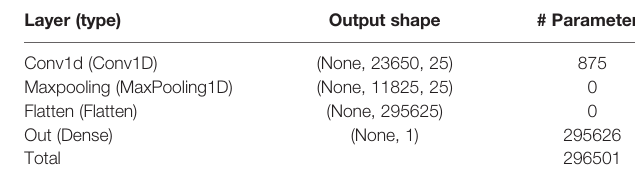
FIGURE 1 | Plot of model averaged weight effects against weight index in the output layer of the simulated QTLMAS2010 data. The true major additive (including the additive part of the epistatic) QTLs are marked in red + and the dominance QTLs are in green ×.